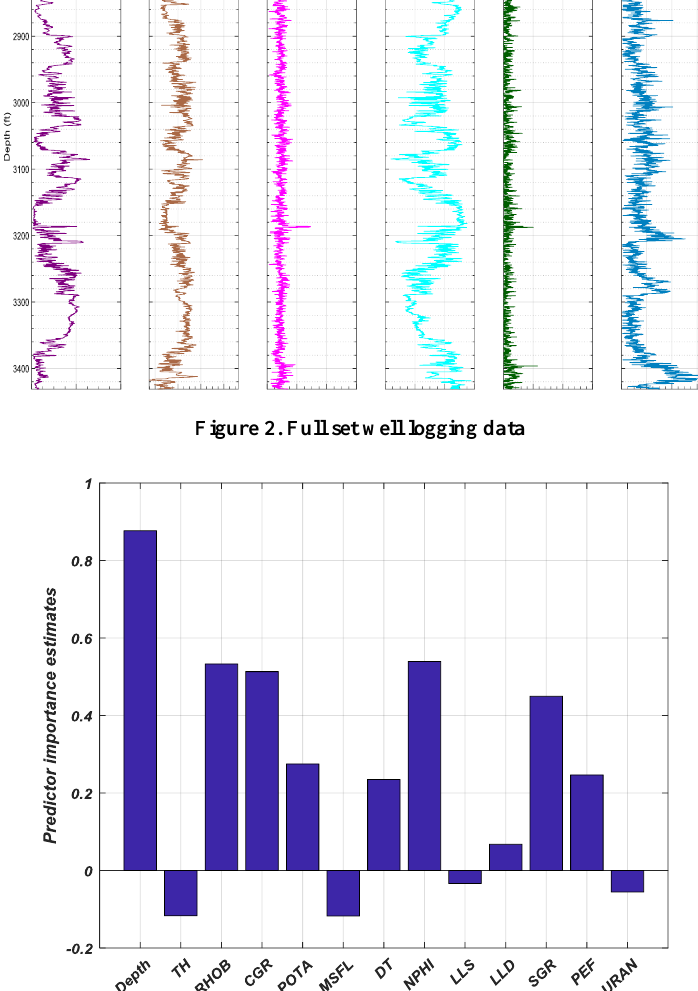
Figure 3. Feature ranking by random